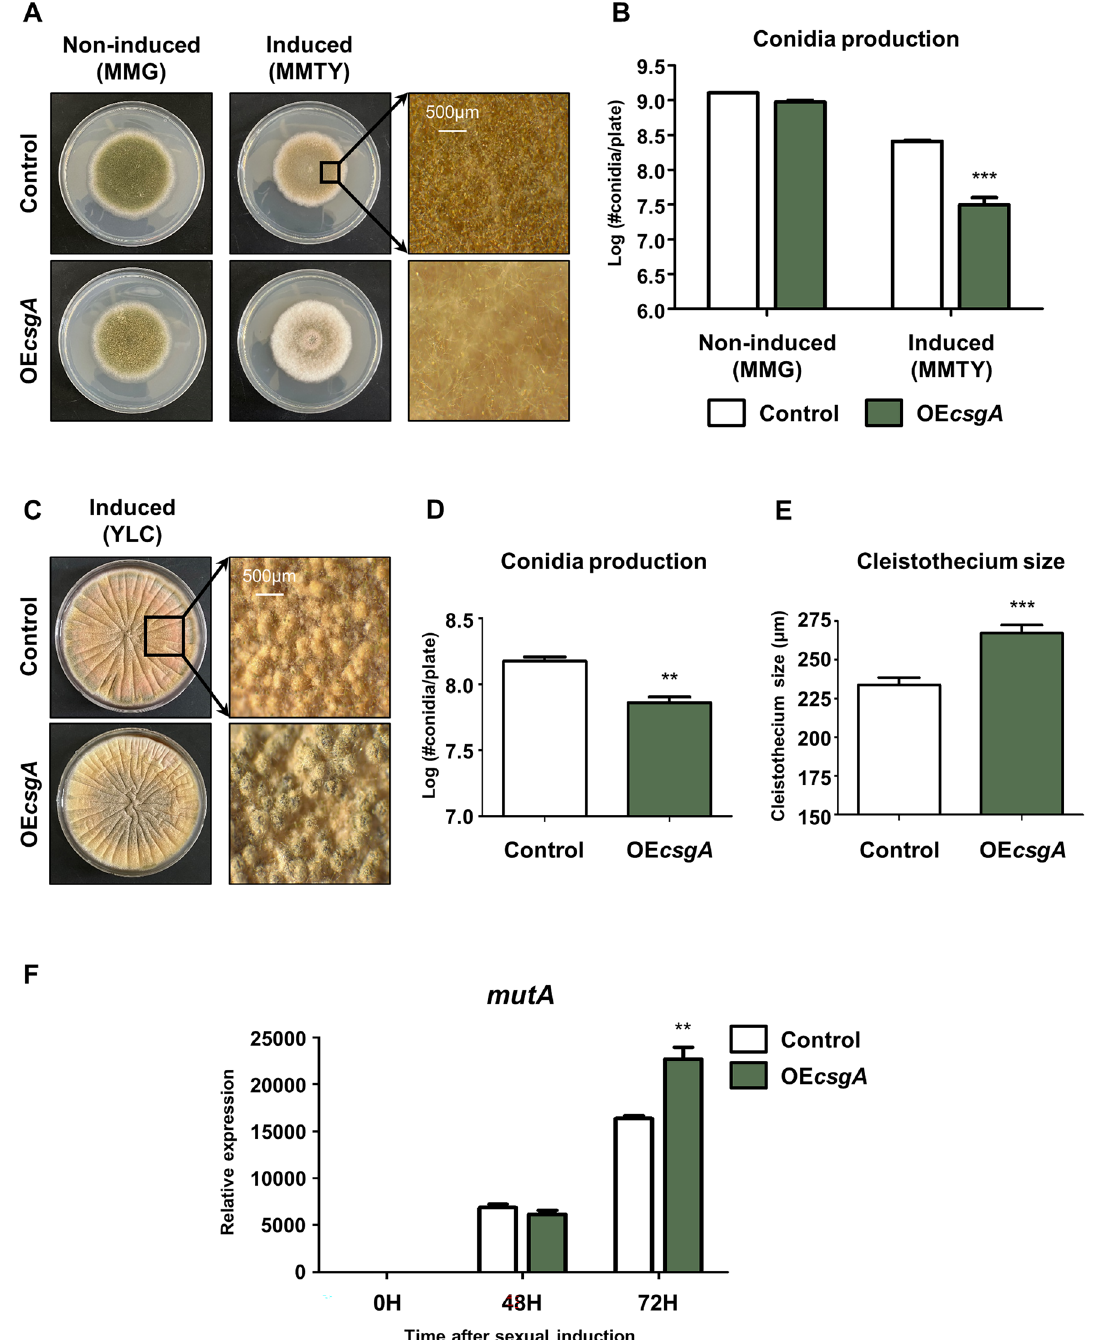
Figure 4. Effect of csgA overexpression. ( A ) Colony photographs of control (THS30) and OE csgA (THJ27.1) strains point-inoculated on solid MMG and MMTY and grown for 5 days at 37 °C in light conditions. ( B ) Quantitative analyses of conidia production in each strain shown in ( A ). ( C ) Colony photographs of control (THS30) and OE csgA (THJ27.1) strains point-inoculated on solid YLC and grown for 5 days at 37 °C in light conditions. ( D ) Quantitative analyses of conidia production of each strain shown in ( C ). ( E ) Quantitative analyses of sexual development in each strain by measuring single cleistothecium size. ( F ) mRNA expression levels of mutA in each strain grown on solid YLC after sexual development induction. ** p < 0.01, *** p <